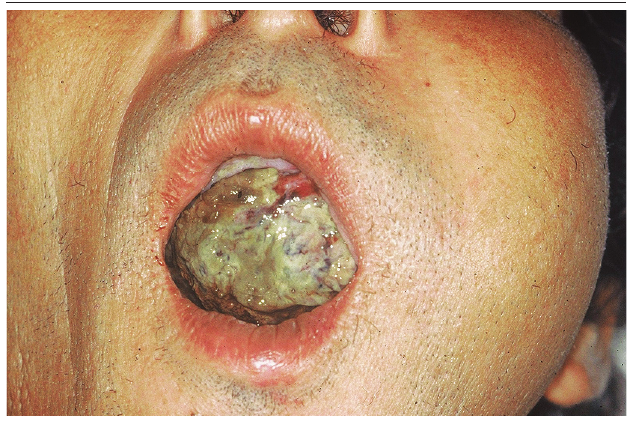
figurE 5 − Mild pleomorphism and presence of numerous malignant cells (HE, 400×) HE: hematoxylin and